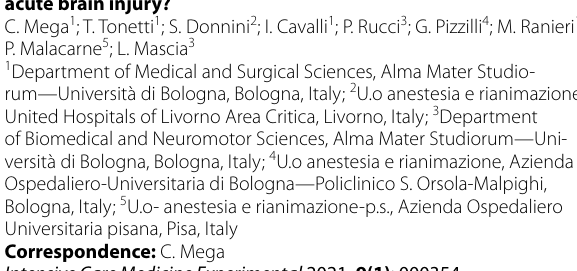
Figure 1. Probability of ARDS as a function of maximum Vt/PBW. Conclusion. Tidal volume, plateau pressure and respiratory rate